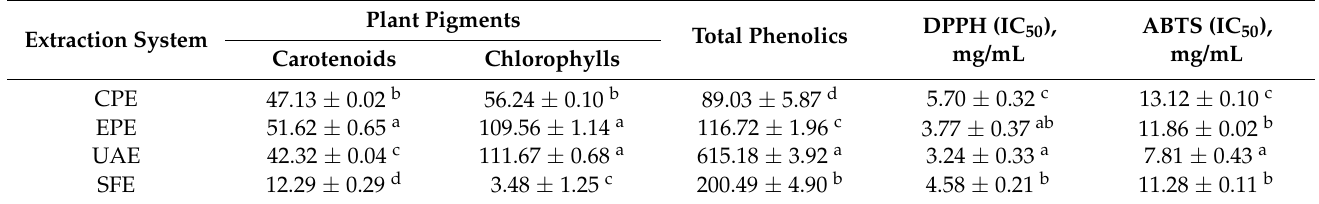
Table 4. Pigments, polyphenols and antioxidant activity of the sinami oils that were obtained using the four extraction